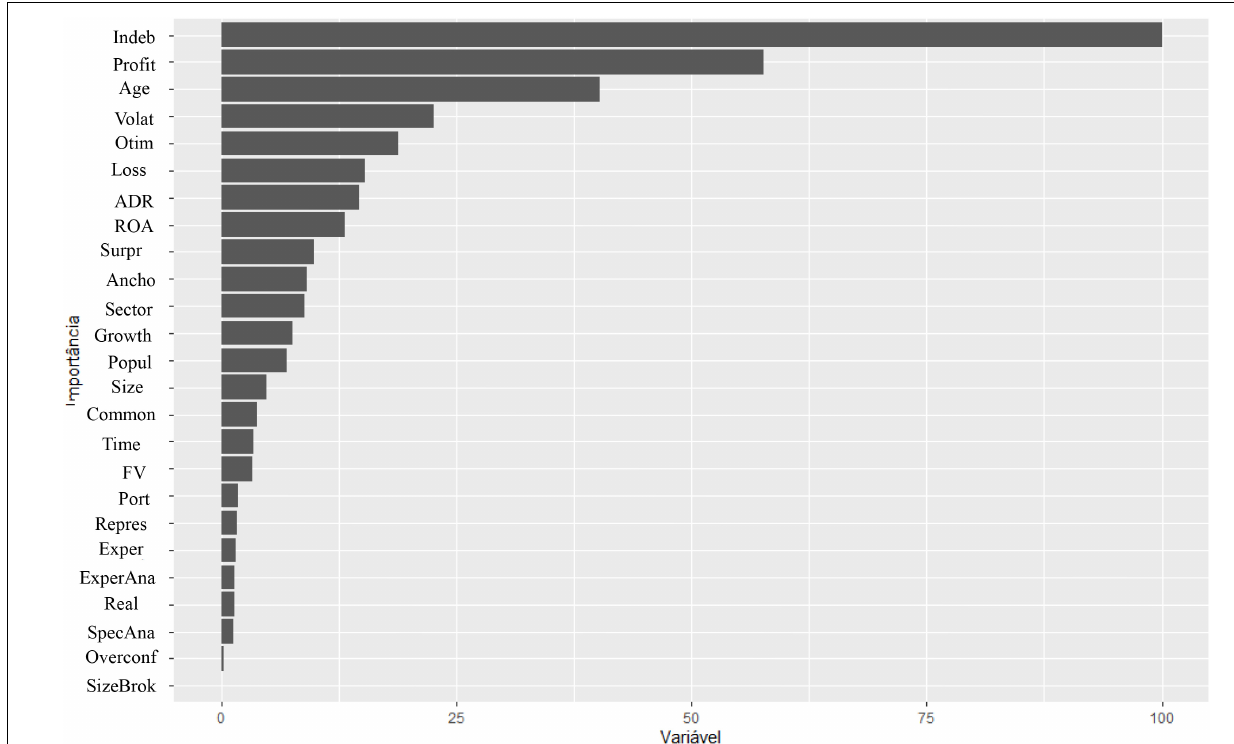
FIGURE 3 | Importance of variables in Random Forest (RF).